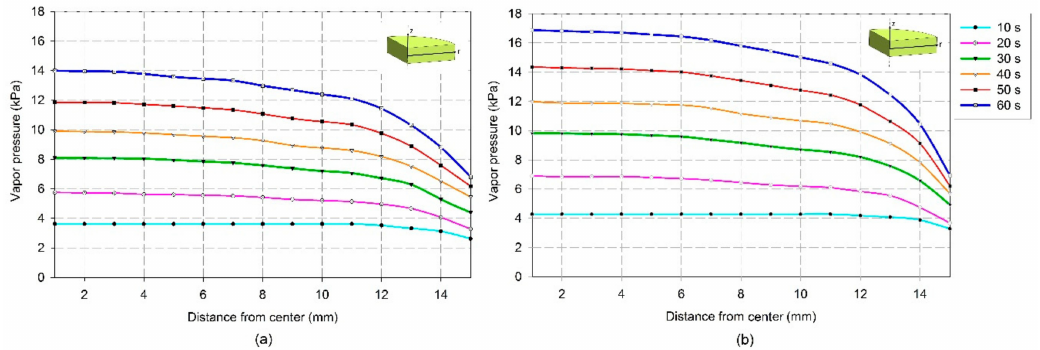
Figure 14. The vapor pressure profiles of ( a ) unripe bananas, and ( b ) ripe banana.